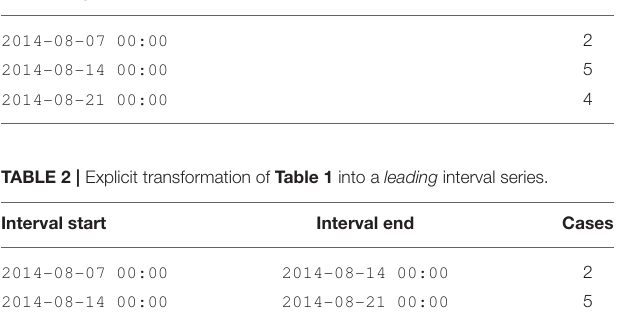
TABLE 1 | Sample historical weekly epidemiological time series consisting of timestamps and case counts. Timestamp Cases